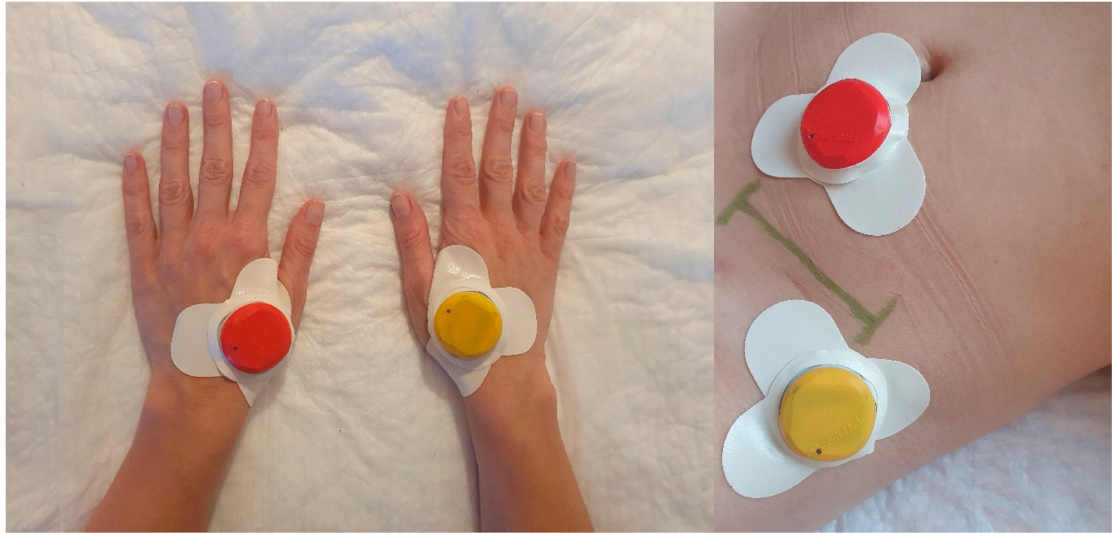
Figure 2. Distribution of four portable electro-simulators at enrolled